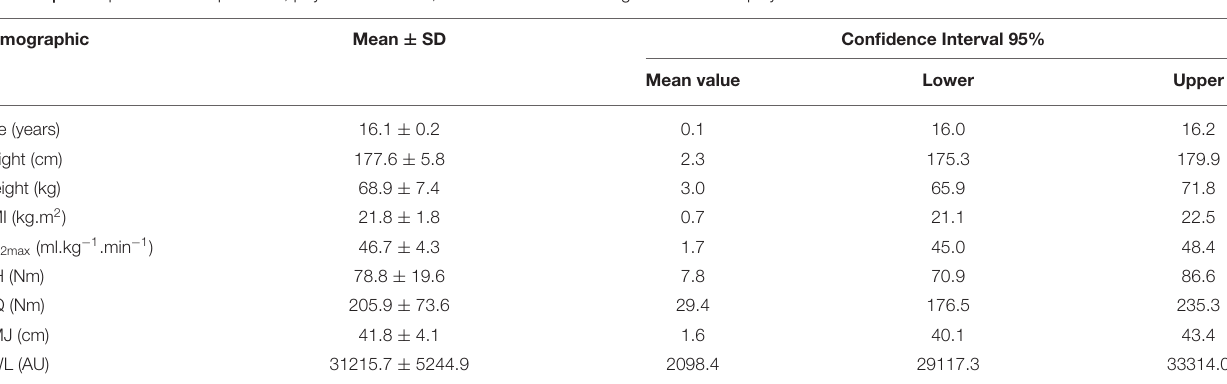
FIGURE 1 | Timeline of monitoring on workload training and evaluations in the entire study. W, week; TS, training sessions; ASS, assessment stages. TABLE 1 | Description of anthropometric, physical indicators, and accumulated training load of soccer players under